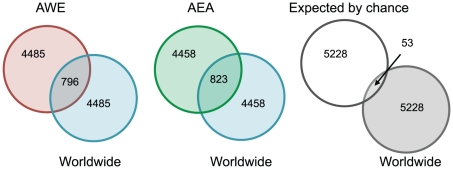
Venn diagrams showing the overlap between lower tails of rank statistics from the worldwide analysis and each population subset analysis.The Venn diagram on the right shows the overlap expected between the results of the worldwide analysis and a set of randomly drawn SNPs.